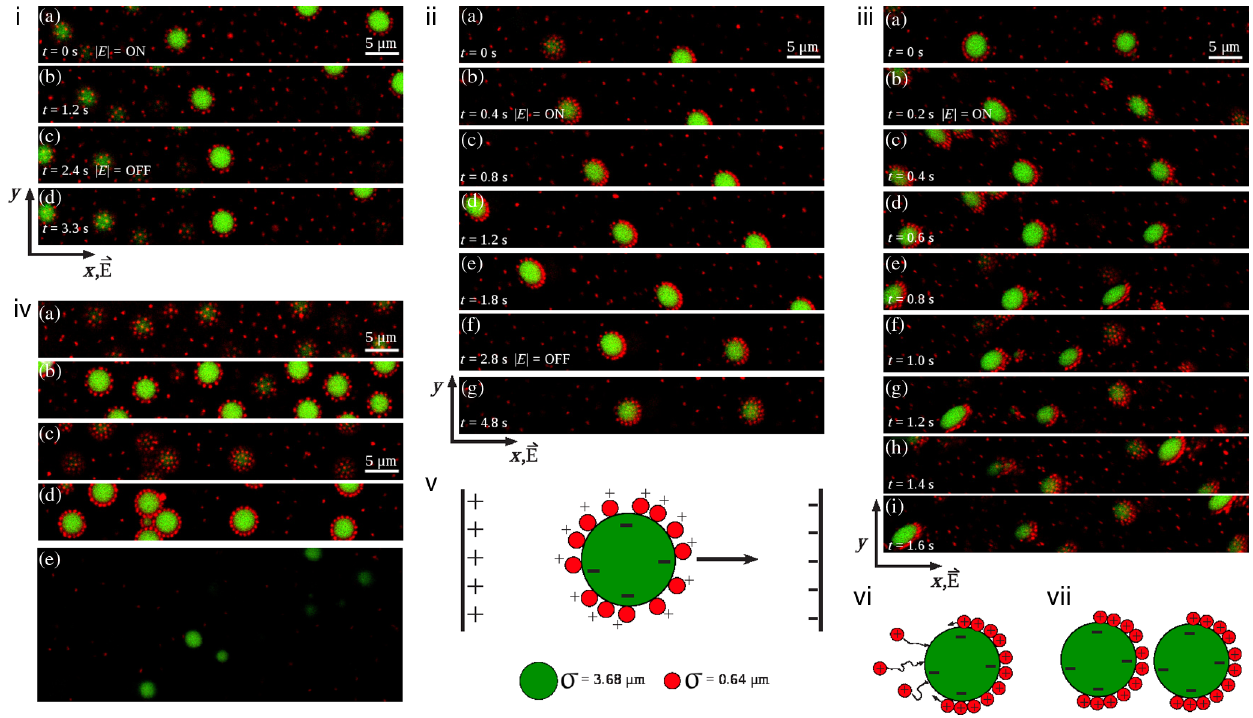
FIG. 4. Electrophoresis experiments of clusters made of large negatively charged ( σ L ¼ 3 . 68 μ m) and small positively charged colloidal particles ( σ S ¼ 0 . 64 μ m). (ia) – (id) Time series of confocal images recorded for a field strength j E j ¼ 11 V = mm. The clusters move towards the negative electrode, indicating that the net charge on the clusters is positive. (iia) – (iig) Time series of images recorded for j E j ¼ 29 V = mm. The small positively charged particles “ crawl ” over the surface to one pole of the large, negatively charged particle. Note that the large particles appear deformed due to their fast movement compared to the line scanning speed of the microscope. (f) After the field is turned off, the particles redistribute again isotropically over the surface. Before this process is completed, the bare side of the large particle remains more vulnerable to the attachment of other, additional positively charged small particles that were previously in solution. (iiia) – (iiii) Images from a time series recorded at j E j ¼ 77 V = mm. In the first image (a), no field is applied. During the first ∼ 0 . 6 s in which the field is applied (b) – (d), clusters move towards the negative electrode. Small particles (red) accumulating on one side of the large particle (green) cause an anisotropic charge distribution on the cluster. At some point between 0.4 and 0.6 s after the field is turned on (d),(e), the clusters as a whole reverse direction (e) – (i), indicating that a sufficient number of small particles has been pulled from the large particle by the electric field to reverse the net charge of the cluster. (iva) – (ivd) Confocal microscopy images of clusters before (a),(b) and after (c),(d) an electric field ( j E j ¼ 29 V = mm) is applied in 9 cycles of 2.5 s each. In between these cycles, the field is switched off for 7.5 s. (e) After an electric field ( j E j ¼ 77 V = mm) is applied in 9 cycles of 2.5 s each (the field is switched off for 7.5 s between each cycle), bare large negatively charged particles are found near the positive electrode, indicating that (almost) all of the small particles have been pulled off. Schematic representations (not drawn to scale) of (v) an unpolarized, net positively charged cluster moving in an electric field, (vi) the adsorption of extra small particles on a polarized cluster, and (vii) the attachment of one polarized cluster to another